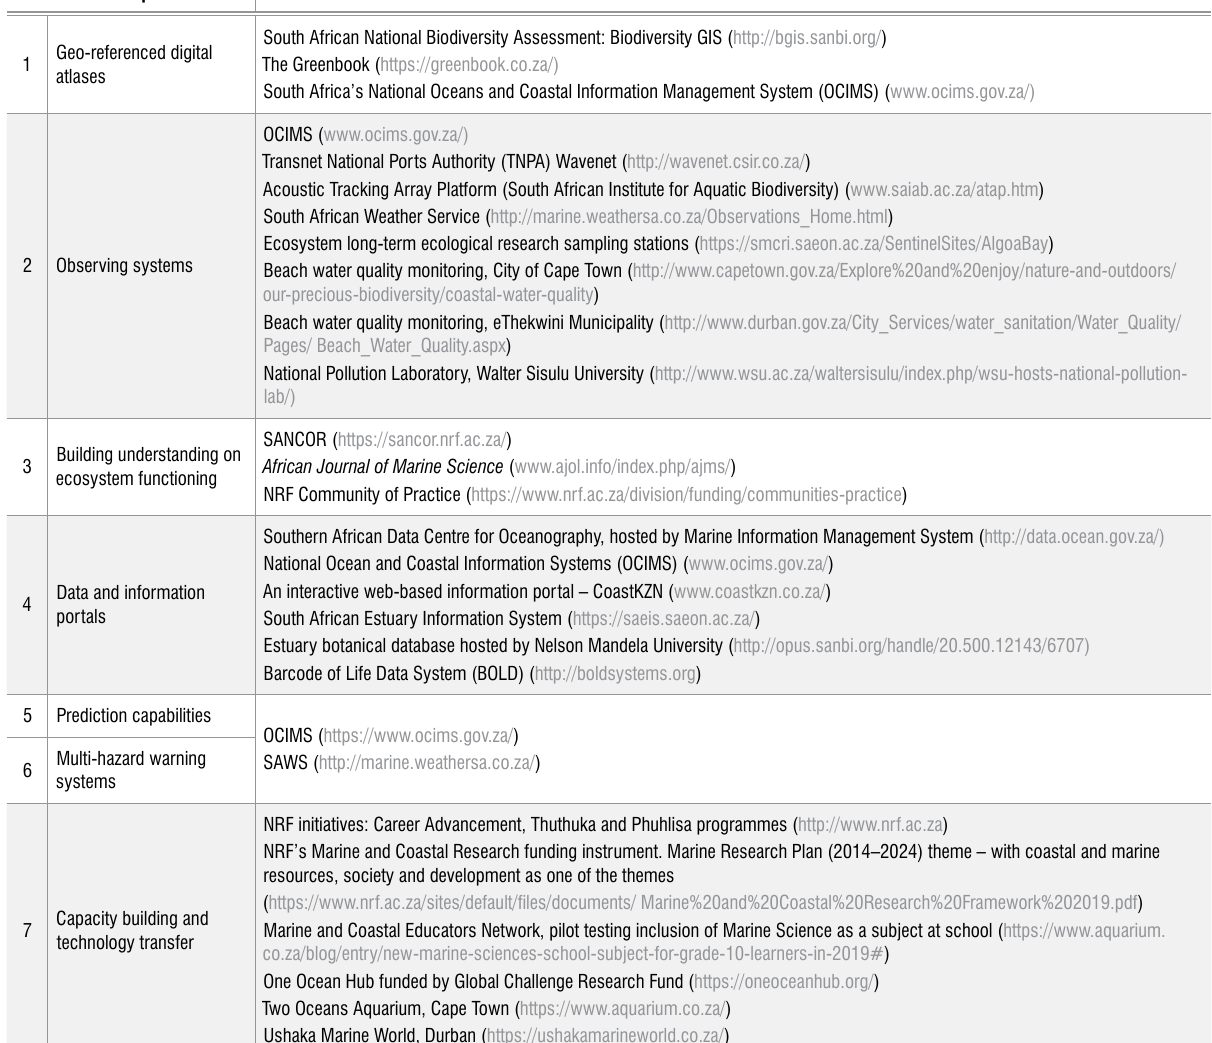
Summary of existing scientific initiatives aligned with the UN Decade’s priorities supporting coastal management in South Africa UN Decade priorities EXISTING INITIATIVES IN SOUTH